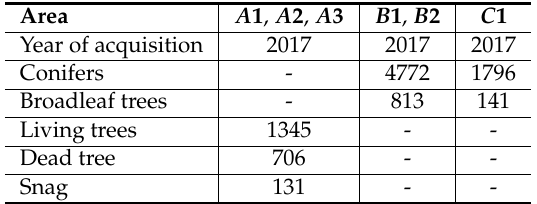
Table 4. Properties of reference plots manually